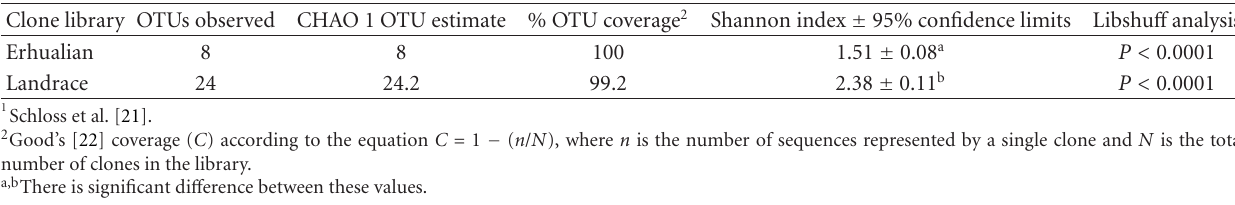
Table 3: Coverage and Shannon Index calculated using MOTHUR 1 for each methanogen 16S rRNA gene clone